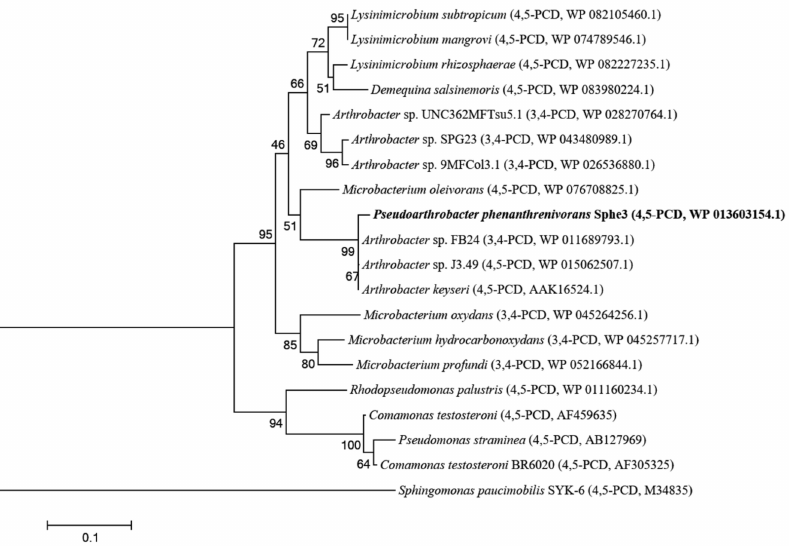
Figure 3. Phylogenetic tree of PcaA and other PCA dioxygenases. The dioxygenases used for the construction of the phylogenetic tree presented >66% identity with PcaA. The tree was constructed with the neighbor joining algorithm. The percentage of replicate trees in which the associated dioxygenases clustered together in the bootstrap test (500 replicates) is shown next to the branches. The scale bar indicates the number of substitutions per nucleotide position. Accession numbers are in parentheses. 3,4-PCD: PCA 3,4-dioxygenase; 4,5-PCD: PCA